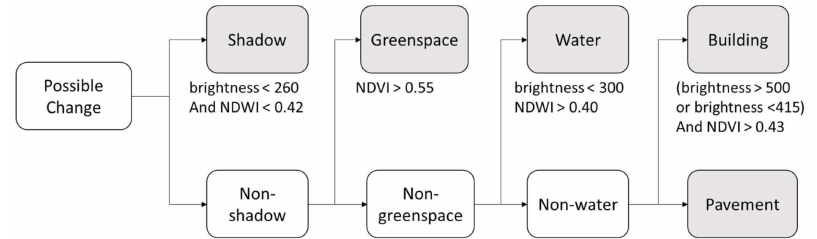
Figure 4. The rule-based classification procedure in Method 1, showing the classification tree and features and thresholds used for